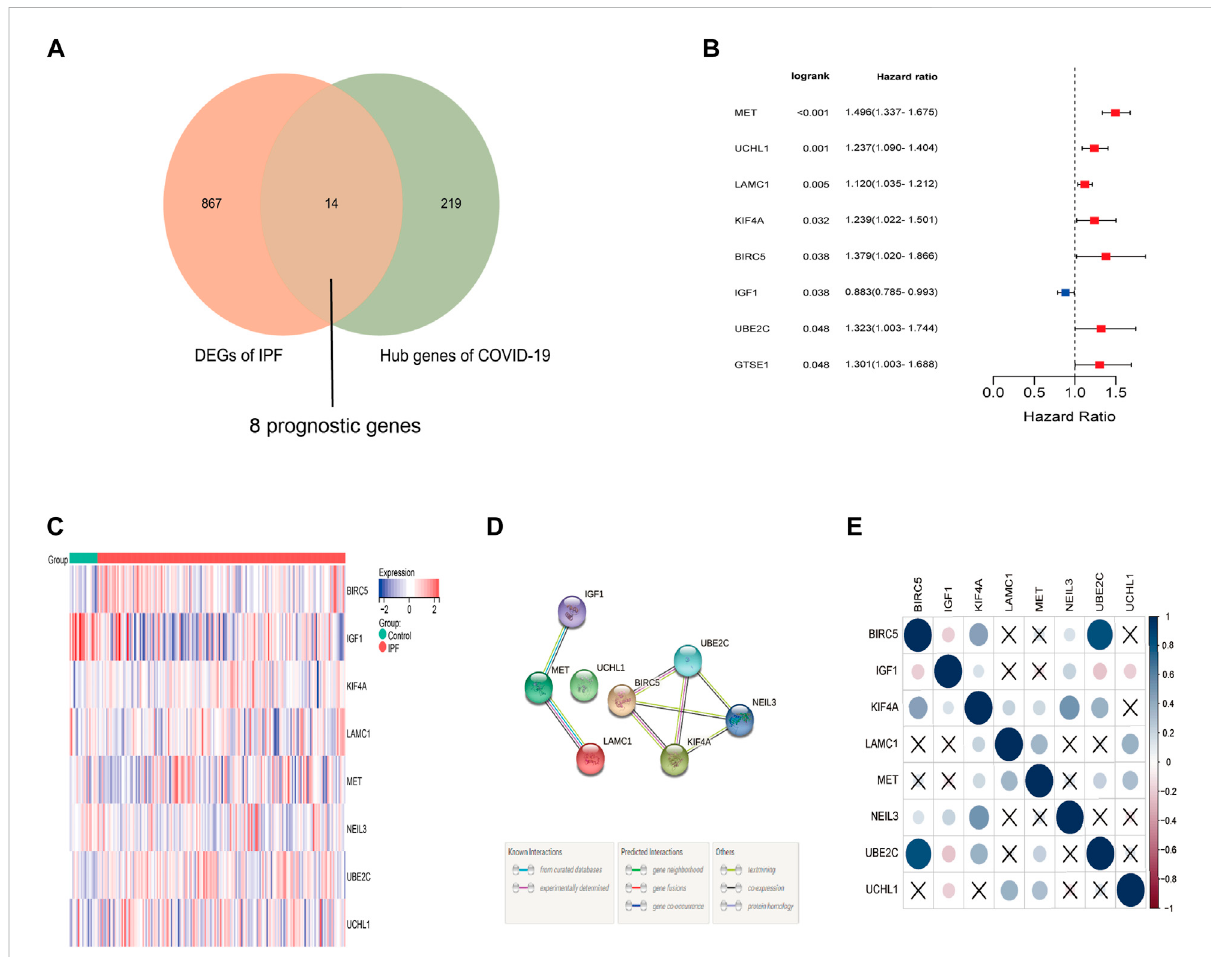
FIGURE 3 Identi fi cation of the prognostic DEGs related to COVID-19 in IPF. (A) Eight prognostic genes related to COVID-19 were differentially expressed between IPF group and normal group. (B) Univariate Cox proportional regression analysis showed that eight differentially expressed prognostic genes related to COVID-19 were signi fi cantly correlated to the survival of IPF patients. (C) The heat map of eight differentially expressed prognostic genes related to COVID-19. Red represents high expression and blue represents low expression. (D) The protein and protein network of eight differentially expressed prognostic genes related to COVID-19. (E) The correlation heat map of eight prognostic differentially expressed genes related to